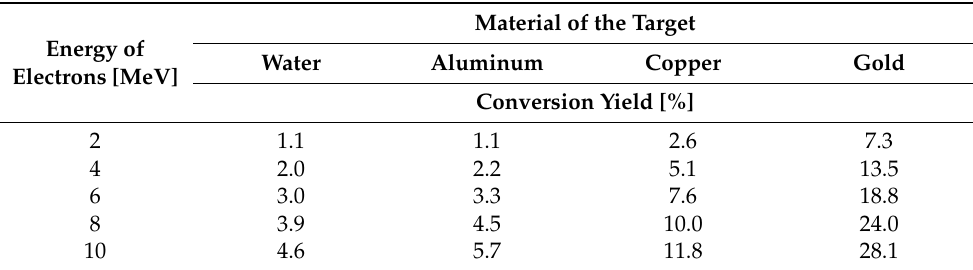
Table 1. Dependence of the electron conversion yield into electromagnetic radiation yield depending on the energy of electrons and material of the target [37].